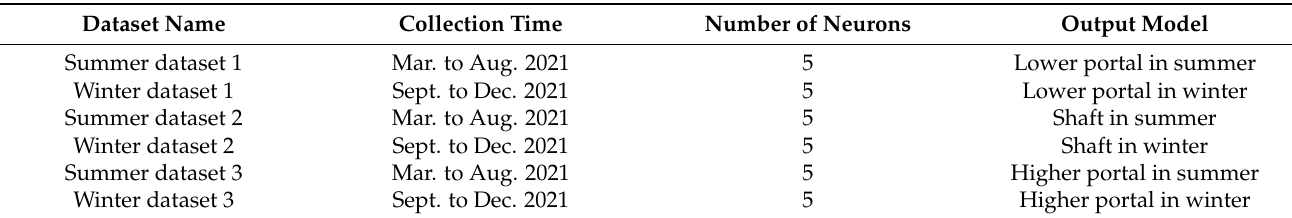
Table 4. Meteorological parameters prediction dataset.